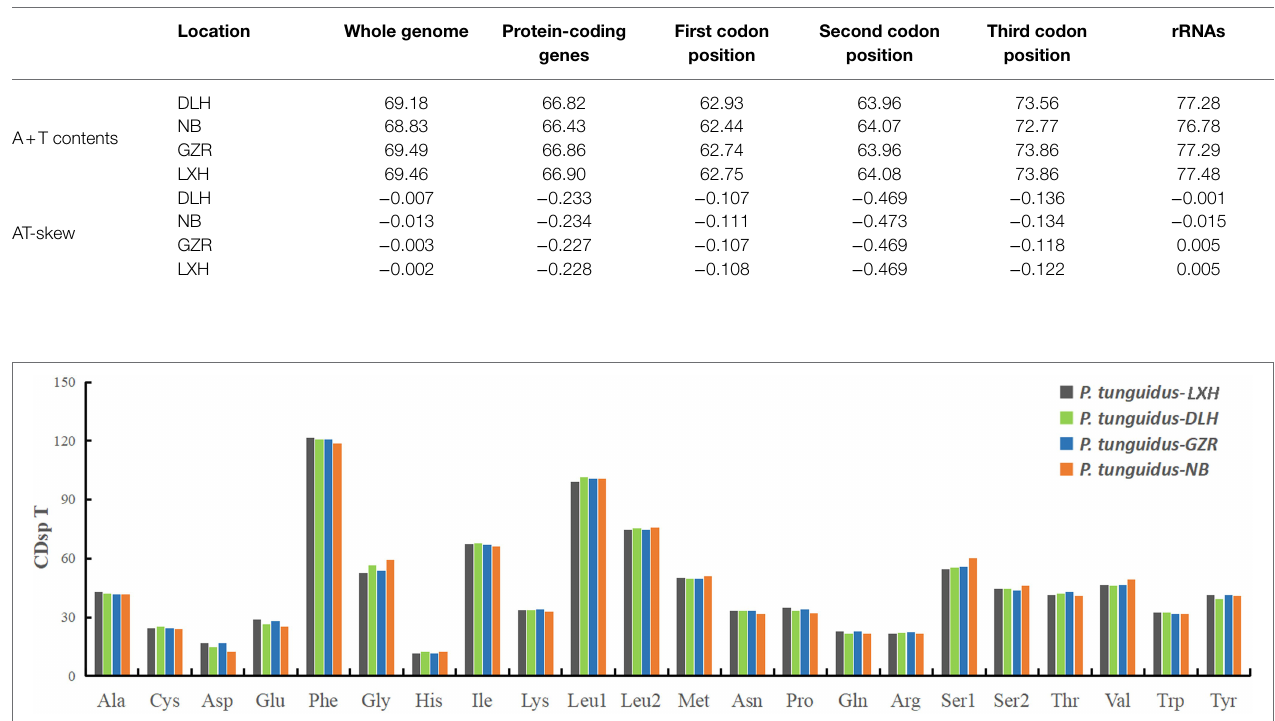
TABLE 2 | A + T contents, AT-skew of the four representative mitogenomes of P. tunguidus